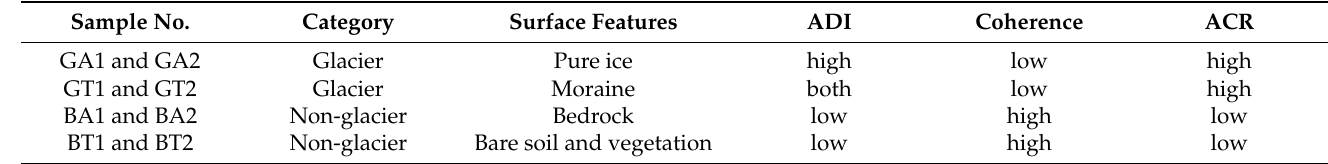
Table 2. Statistics of ADI, coherence, and ACR attributes of selected